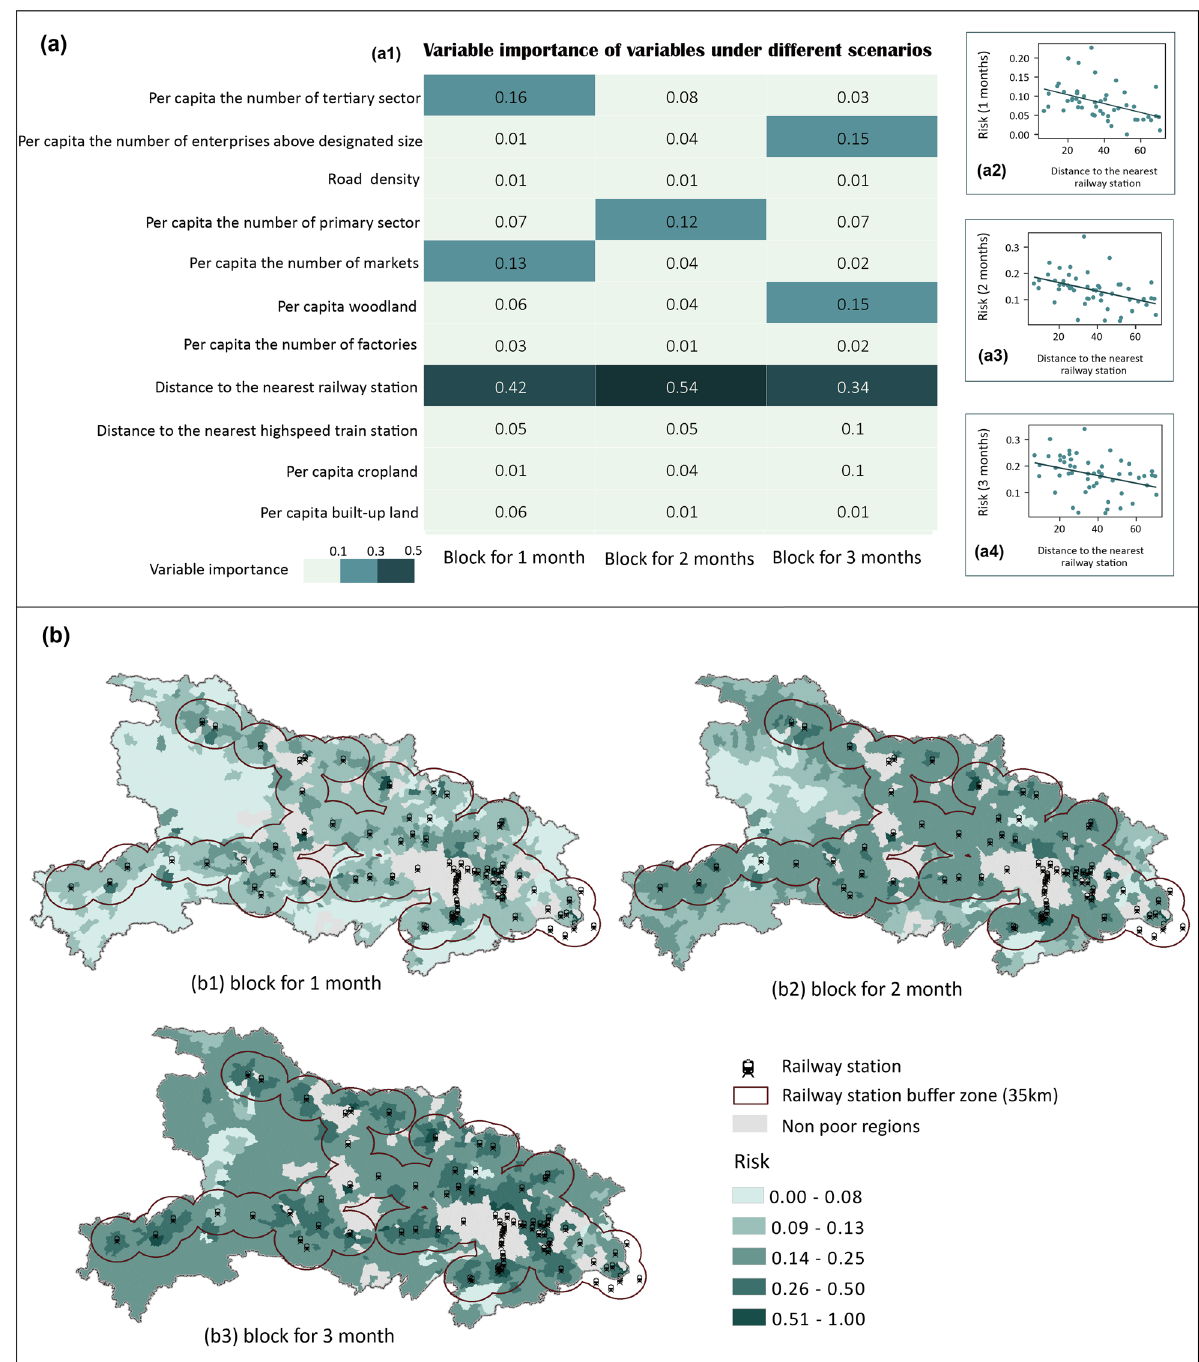
Fig. 4 The town-level importance ranking of various factors and their relationship with the risk of returning to poverty. a The importance ranking of various factors in relation to the risk of returning to poverty using the LMG approach in the multiple linear regression model and the bivariate relationship between risk and the distance to the nearest railway station under 1-, 2- and 3-month lockdown scenarios. b The estimated risk of returning to poverty for each town in Hubei Province under the three lockdown